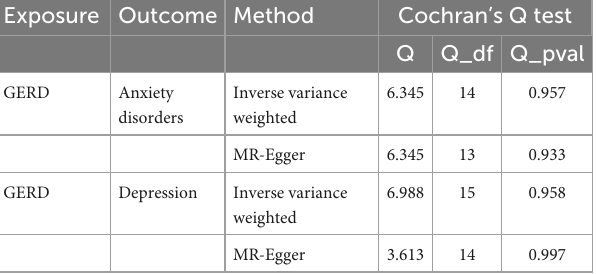
TABLE 4 Results of heterogeneity by the Cochran’s Q test (based on the IVs screened under the genome-wide significance threshold). Exposure Outcome